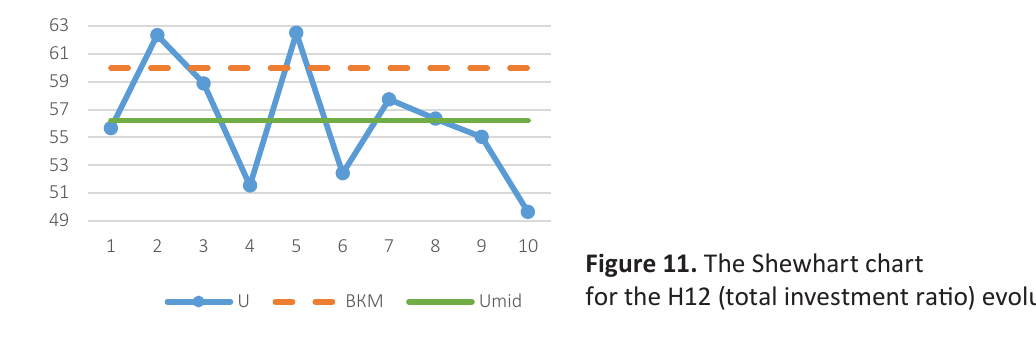
Figure 11. The Shewhart chart for the H12 (total investment ratio) evolution